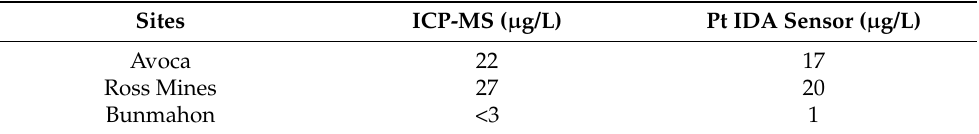
Table 2. Comparison of results obtained with ICP-MS and electrochemical sensors.